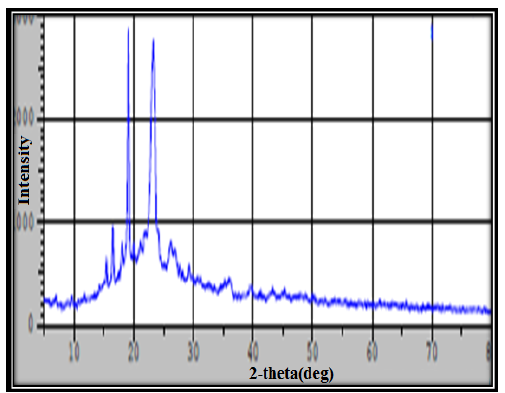
Figure 15. X-Ray Diffraction pattern of the